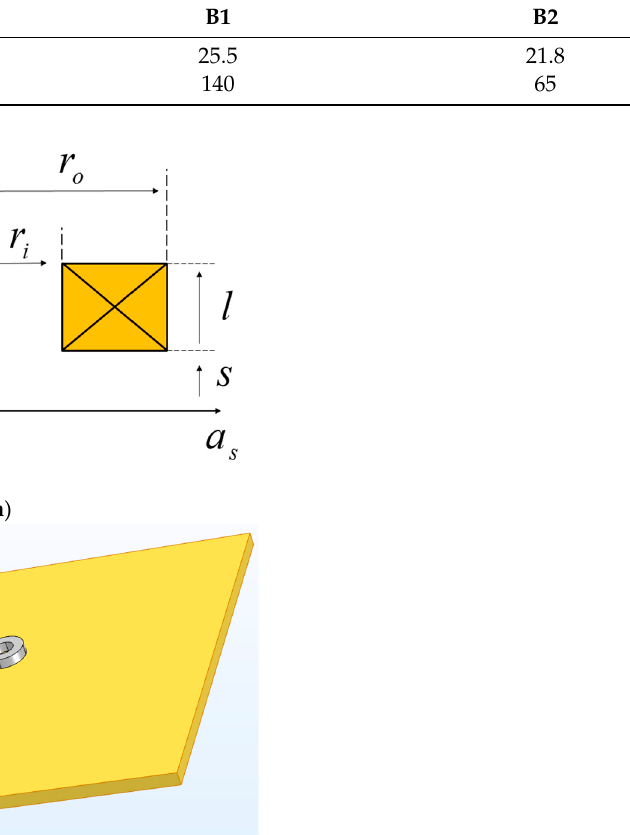
Table 2. Information on the conducting plate.